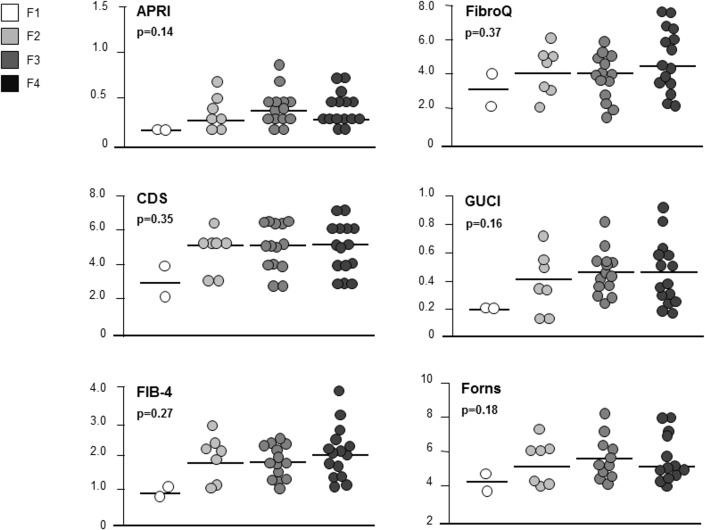
Non-invasive Tests (NITs) values stratification according to post-SVR fibrosis stage.